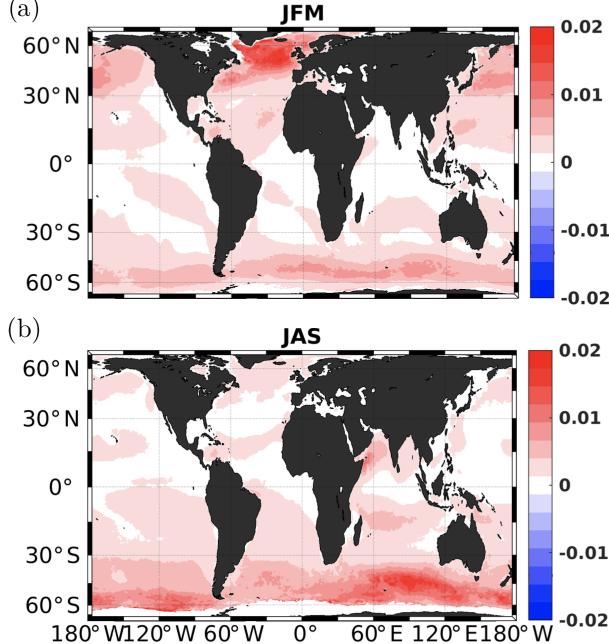
Figure 6. Seasonal difference of 1m depth turbulent kinetic energy (m 2 s − 2 ) between the coupled case (All_CPL2) and the uncoupled case (No_CPL). (a) January, February, and March (JFM); (b) July, August, and September